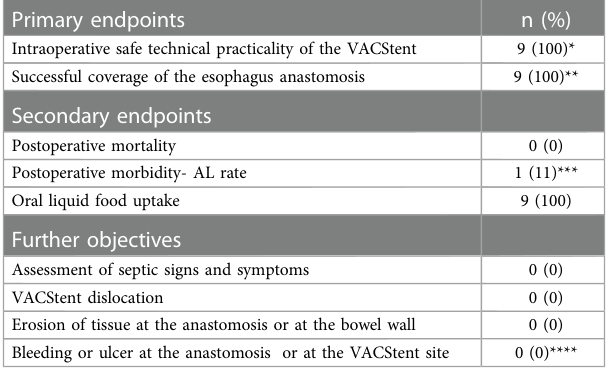
TABLE 3 Endpoints.